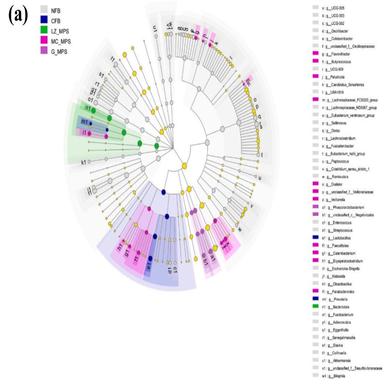
Comparison of gut microbiota using LEfSe and LDA of microbiota among NFB, CFB, LZ-MPS, MC-MPS, and G-MPS groups. (a) Circles indicate Phylogenetic levels from phylum to genus. The diameter of each small circle was proportional to the abundance of the group, (b) LDA scores of 3.0 or greater in bacterial communities, different colored regions represent different groups. NFB, without carbon source group; CFB, inulin treatment group; LZ_MPS, LZ-MPS treatment group; MC_MPS, MC-MPS treatment group; G_MPS, G-MPS t